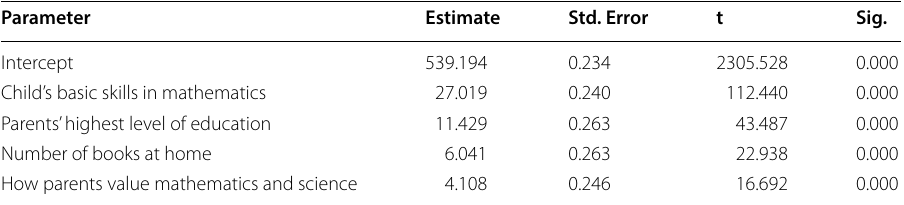
Table 2 Coefficients of “Model 1”